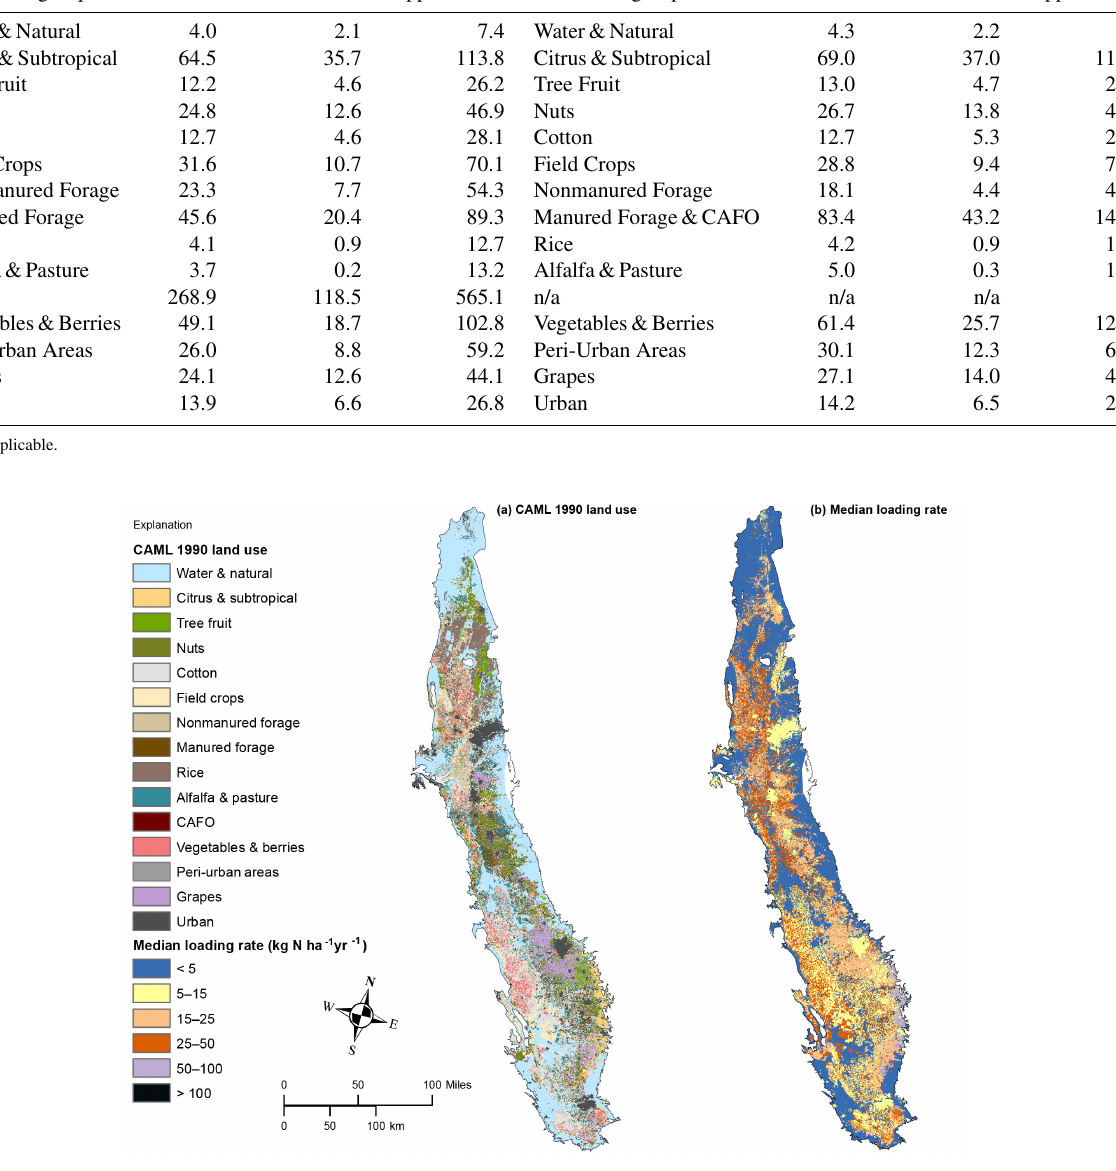
Table 2. Median and 95% credibility interval bounds for estimated nitrogen loading rates by group for scenario 1 and 2. Scenario 1 group